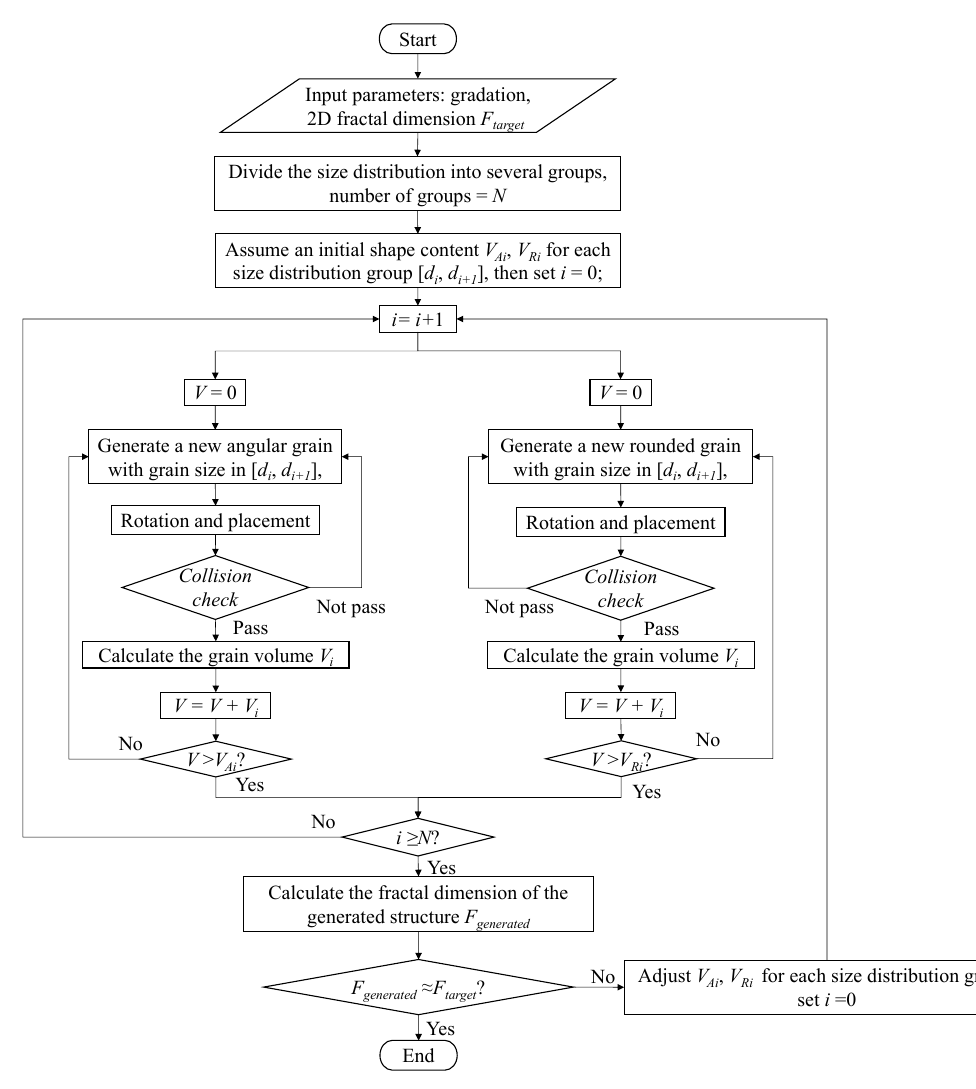
Figure 2. Flowchart of the mesostructure generation process.